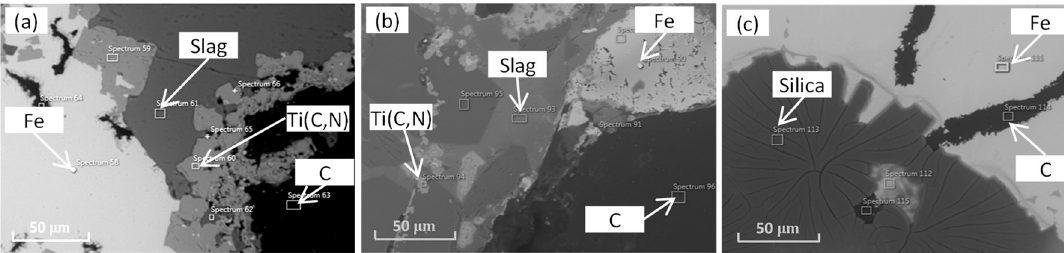
Figure 10. SEM ‐ EDS analysis of the aggregates samples in the lower part of the EBF hearth, campaign 32: ( a ) manual sample MS1; ( b ) manual sample MS2; ( c ) manual sample MS3.